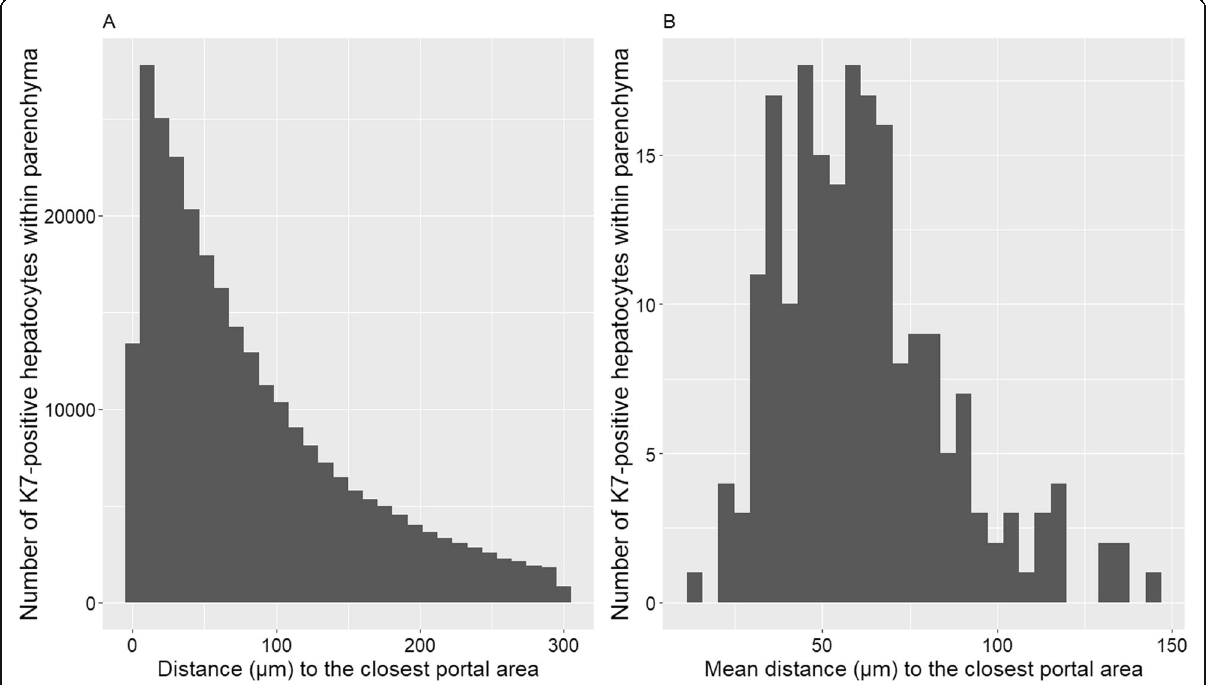
Fig. 4 a The distribution of K7-positive hepatocytes in length ( μ m) from the closest portal area b The mean distance ( μ m) of K7-positive hepatocytes of the closest portal area (both in the entire material of 210